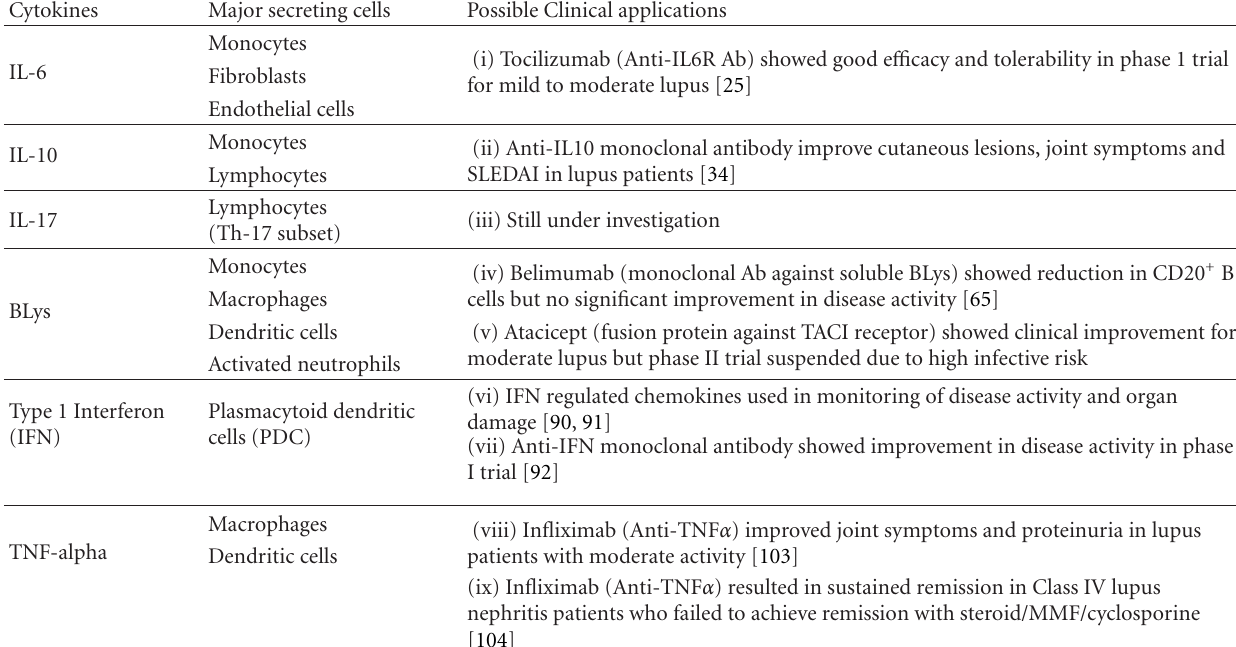
Table 1: Important cytokines in SLE: the major secreting cells and possible clinical